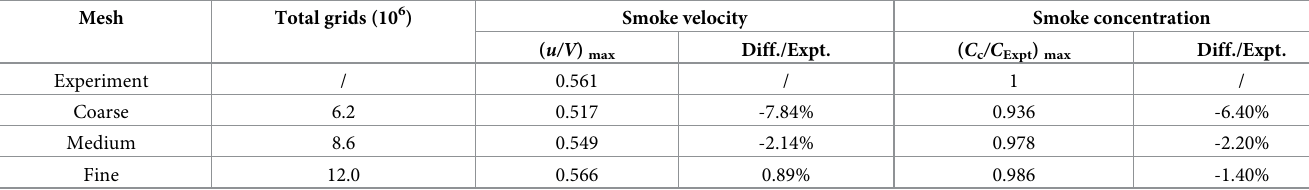
Table 2. Comparison of the experimental and numerical calculation